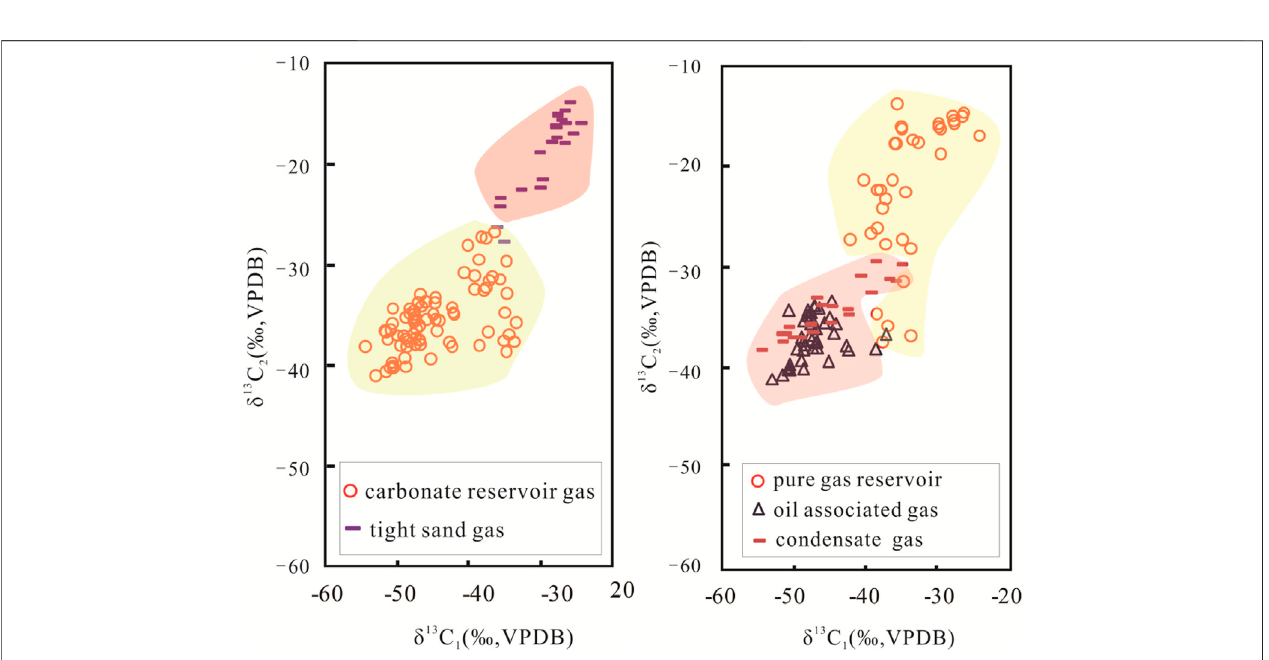
FIGURE 4 | δ 13 C 1 - δ 13 C 2 of deep natural gas in different states and in different reservoirs of Tarim Basin.